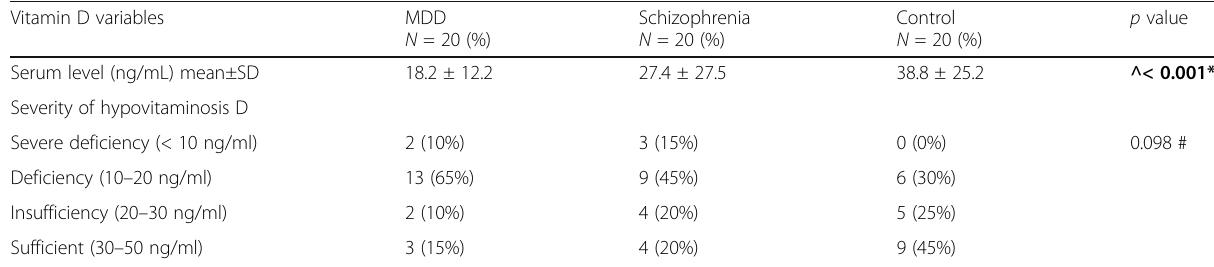
SD standard deviation, MDD major depressive disorder ^ANOVA #Chi-square test *Statistically significant <